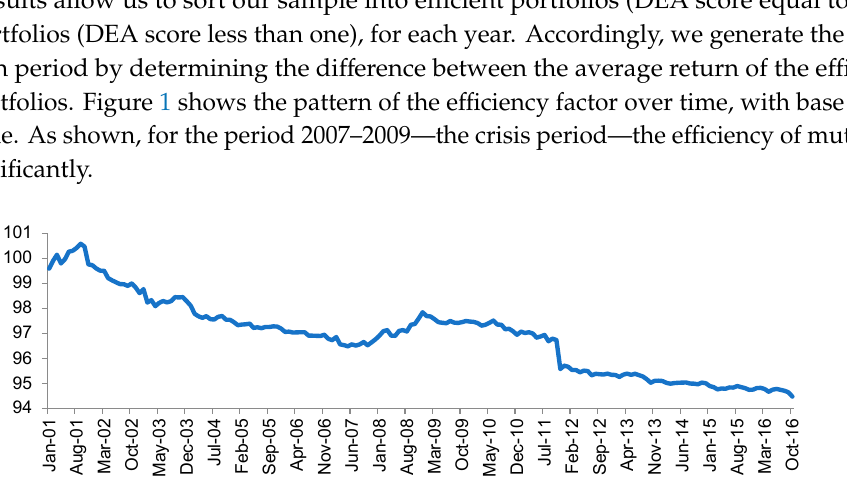
Figure 1. E ffi ciency factor pattern for the period Figure 1. Efficiency factor pattern for the period 2001–2016.